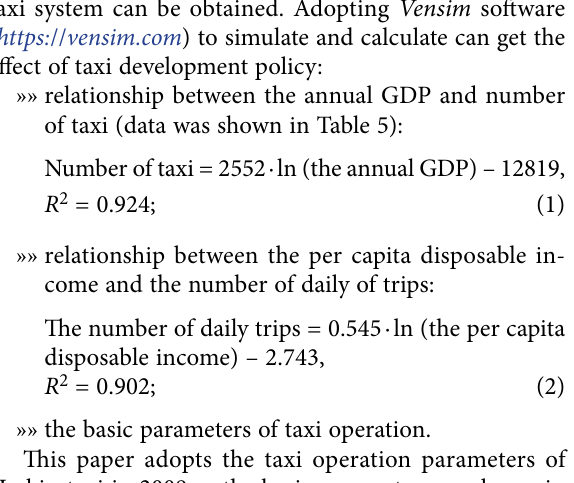
Table 1. The related parameters of Harbin taxi operation